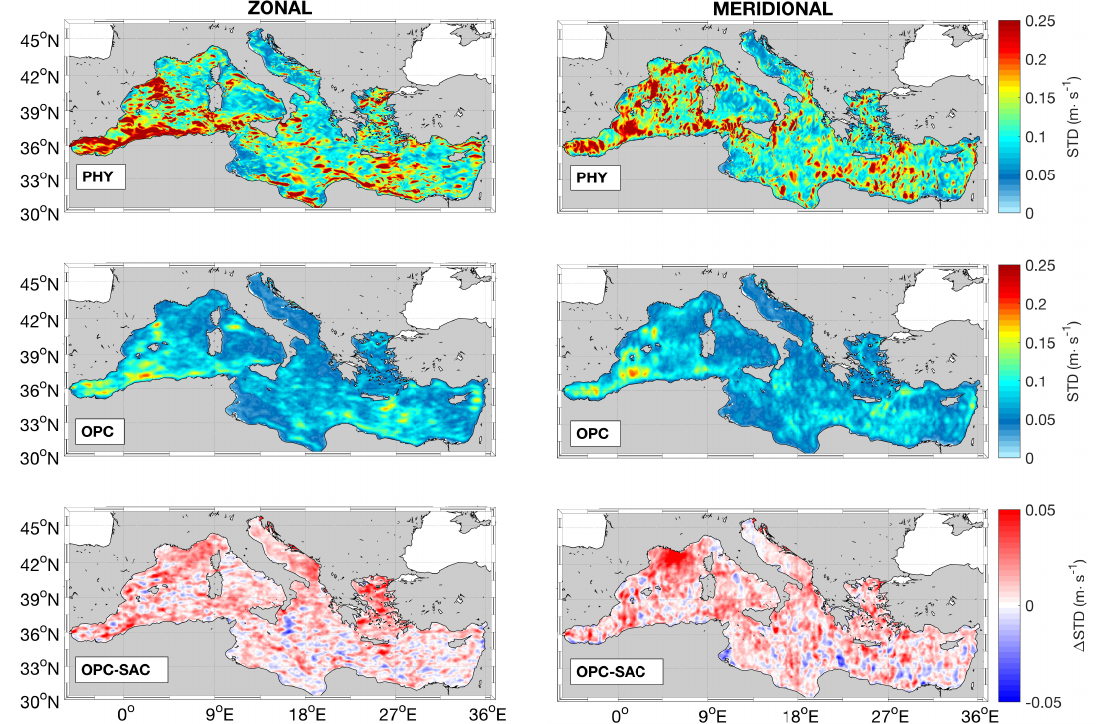
Figure 9. Temporal standard deviation (STD) of the CMEMS PHY and optimal surface currents for the year 2017. ( Top ) CMEMS PHY STD; ( Middle ) STD of the optimal currents (OPC); ( Bottom ) ∆ STD: differences between the OPC and the Synthetic Altimeter Currents (SAC) STDs. ( Left ) and ( right ) columns stand for zonal and meridional currents, respectively.